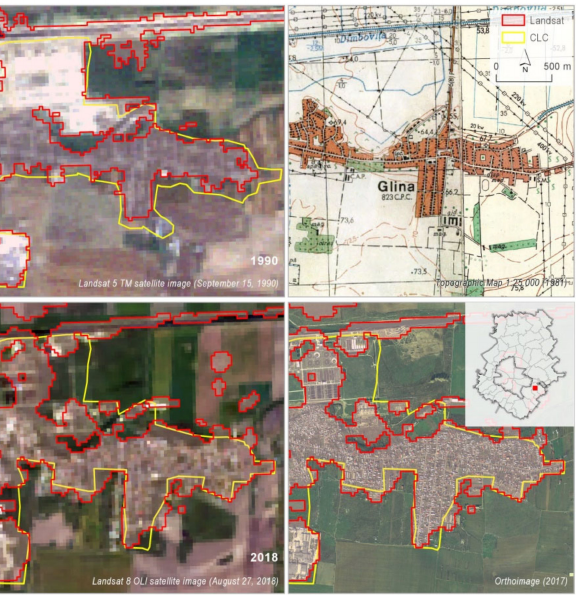
Figure 12. Comparative mapping of the change in the built-up area (1990 / 2018) around Glina village in the southeastern part of Ilfov County. Landsat TM (1990) and OLI (2018) imagery from USGS, topographic map (1981) from the DTM (Military Topographical Directorate) and aerial orthophotos (2017) by ANCPI (National Agency of Cadastre and Land